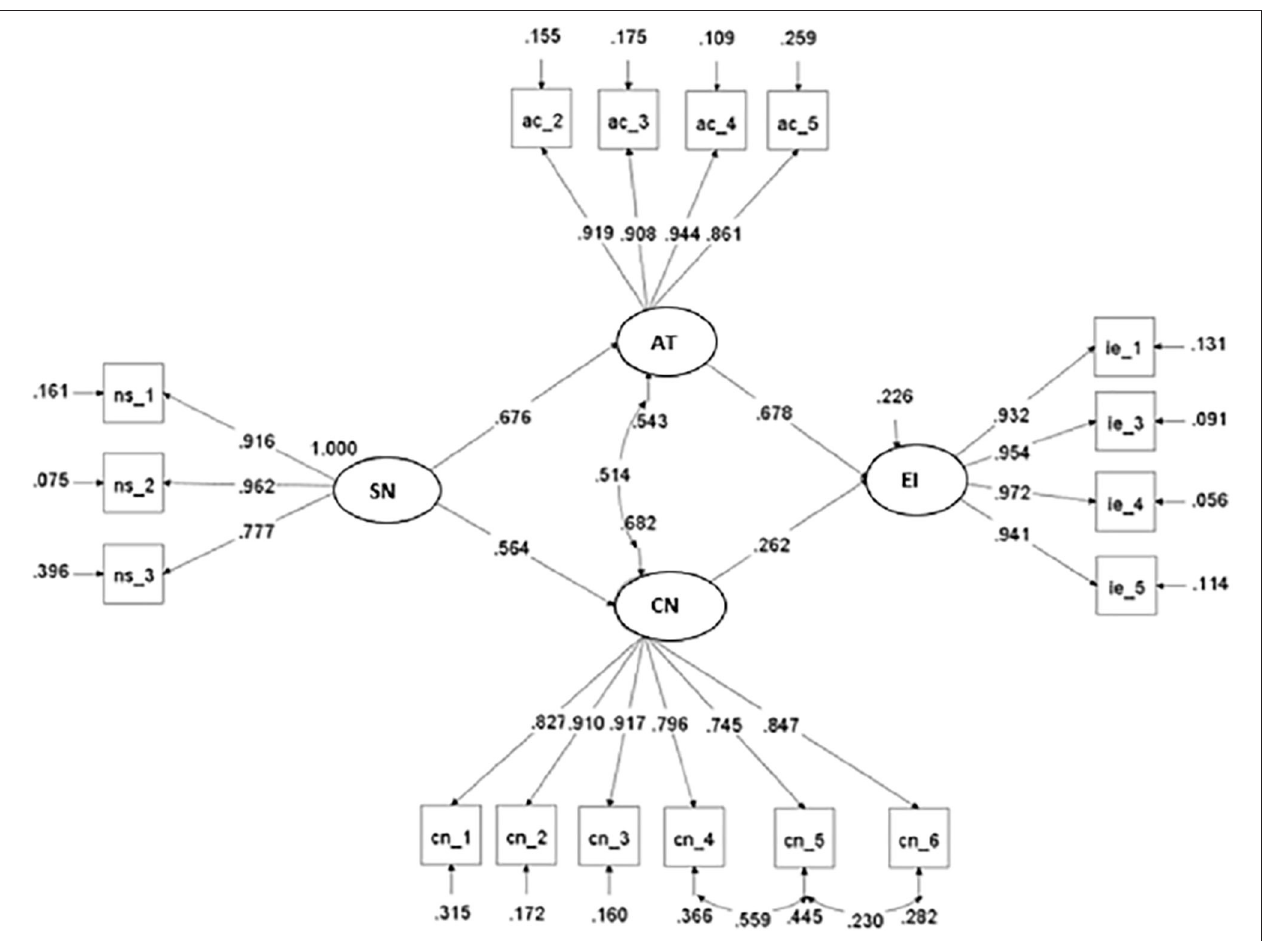
FIGURE 3 | Entrepreneurship intention—structural model.